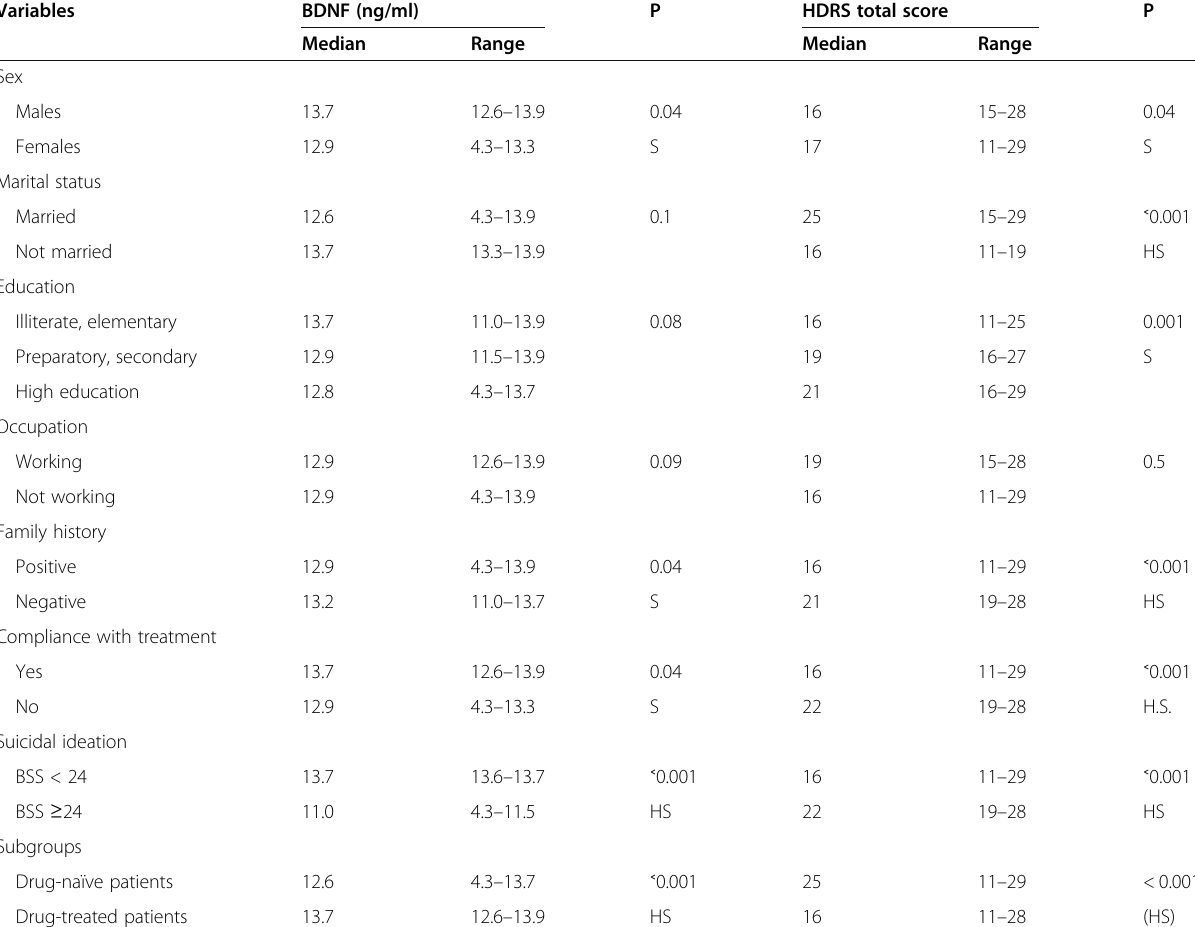
Table 3 Association between BDNF and characteristics of the MDD